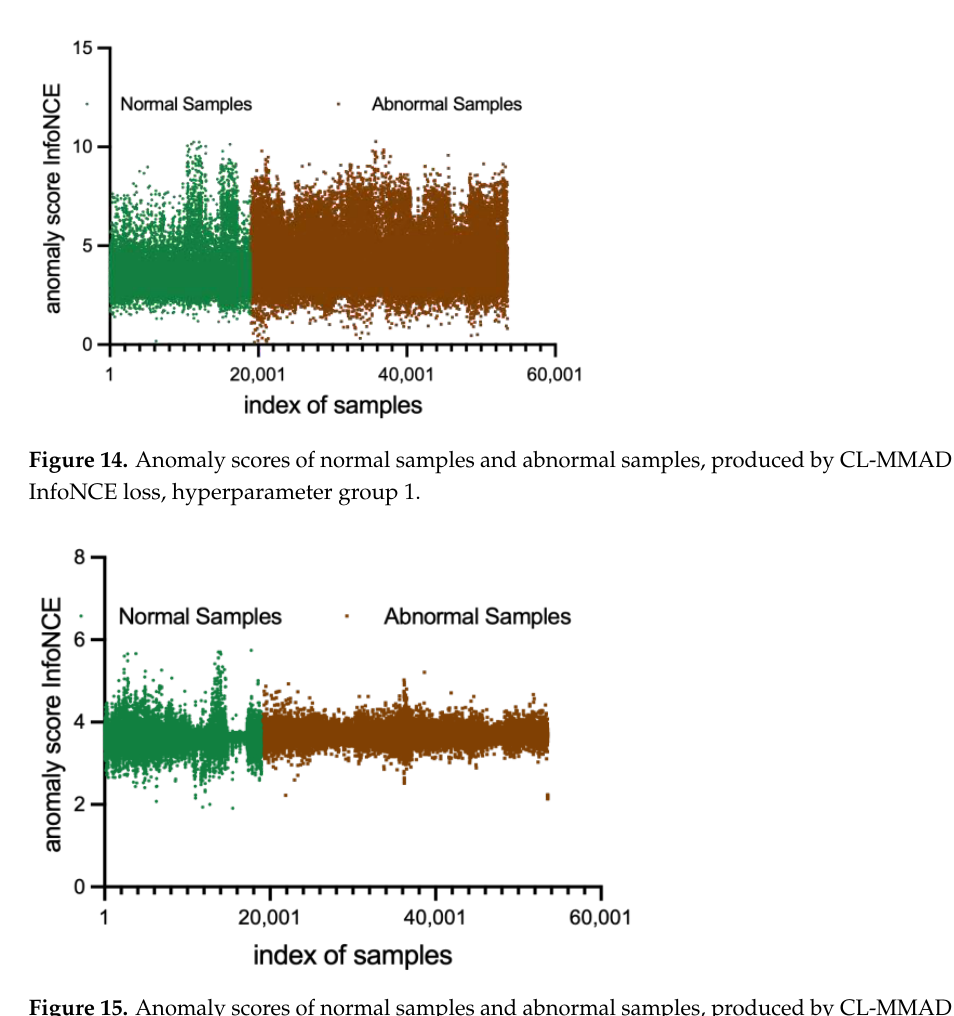
Figure 15. Anomaly scores of normal samples and abnormal samples, produced by CL-MMAD us- ing InfoNCE loss, hyperparameter group 2.